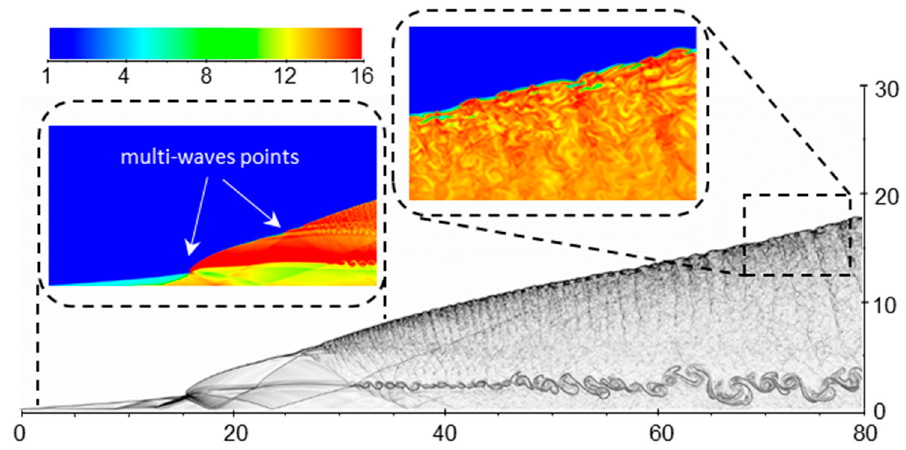
Figure 14. Schlieren plot and temperature contours (sub-plot) with 128 pts / l 1 / 2 for M 0 = 12.5, E a = 60, k = 14,640 and θ = 26°.